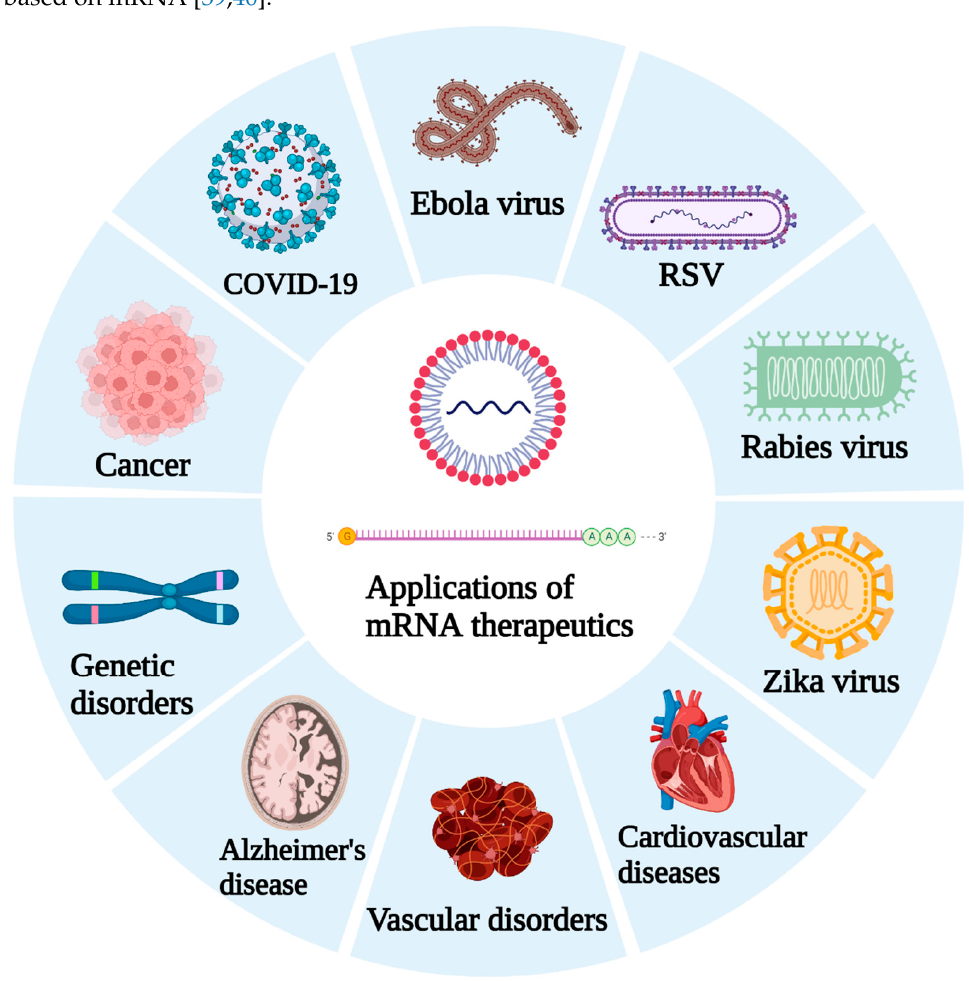
Figure 2. Strategies and potential application of mRNA-based therapeutics. Table 1. Current scenario of the development of mRNA vaccine technology.